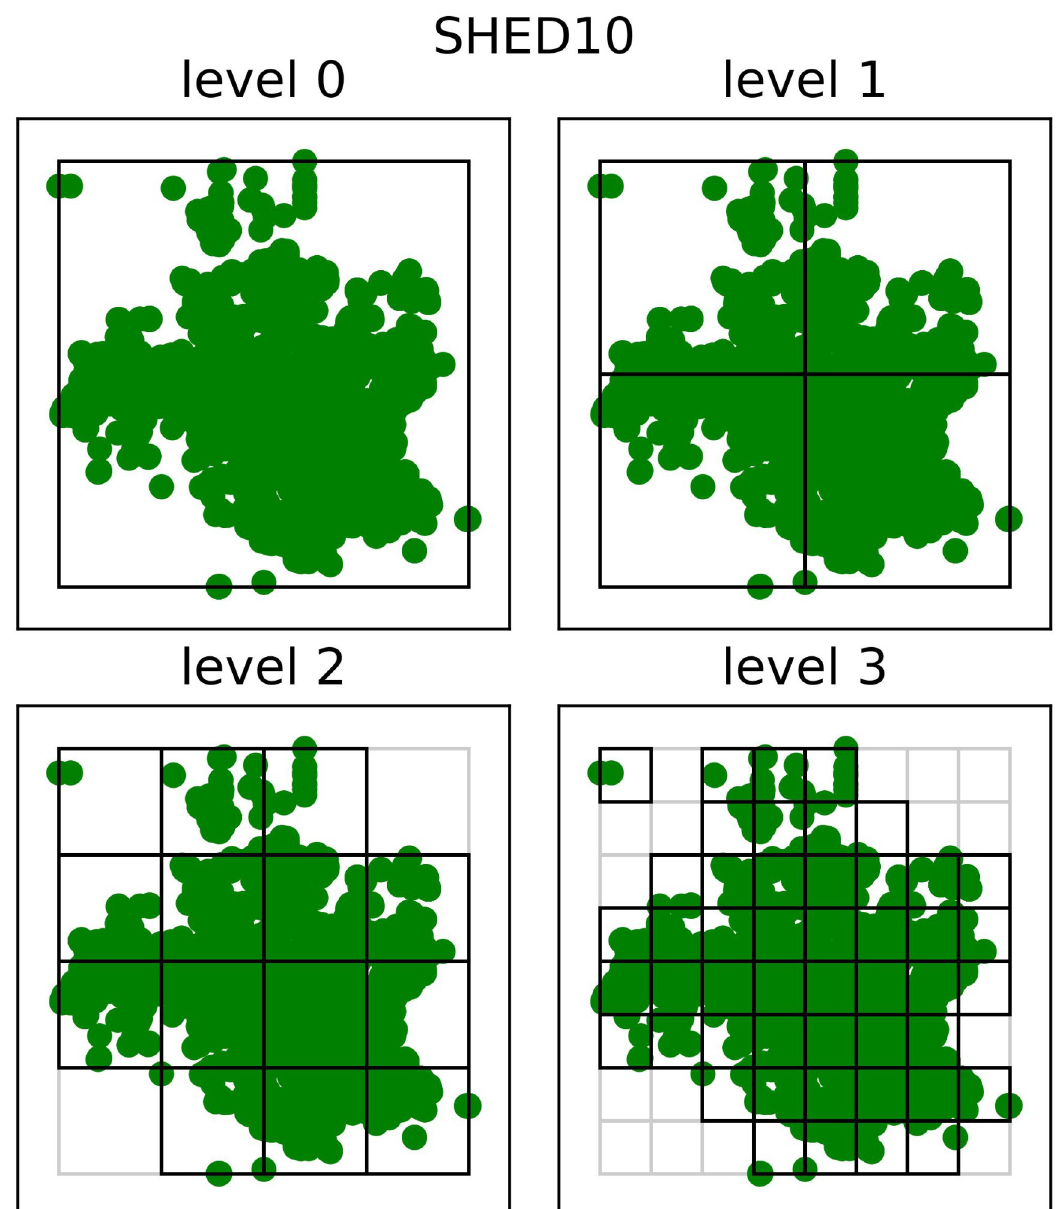
Fig 2. Quad-Tree of SHED10. Latitude and longitude partitioned in the first four